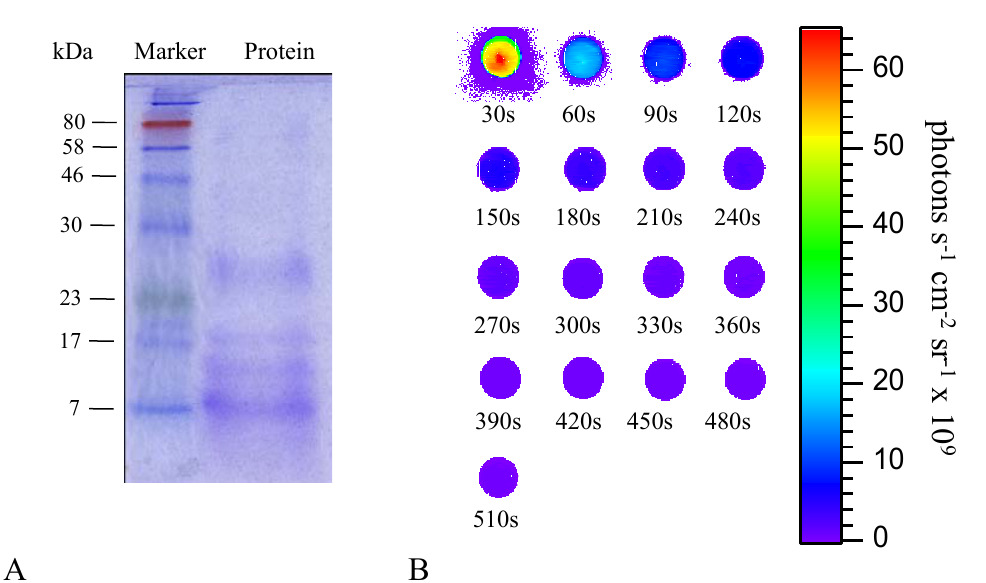
Figure 6. Optical properties of overexpressed Gaussia princeps luciferase: Gaussia princeps luciferase was overexpressed in a bacterial expression system after induction with IPTG and purified using affinity chromatography. SDS-polyacrylamide electrophoresis after Ni-IDA purification displays an enriched protein amount ( A ). 1.36 μ g total protein amount was used for analysis. Determination of total photon flux was performed in an IVIS-100 imaging system over a time period of 510 s after supplementation of coelenterazine ( B ). Quantification of the total photon flux of the spots is shown in Figure 7.